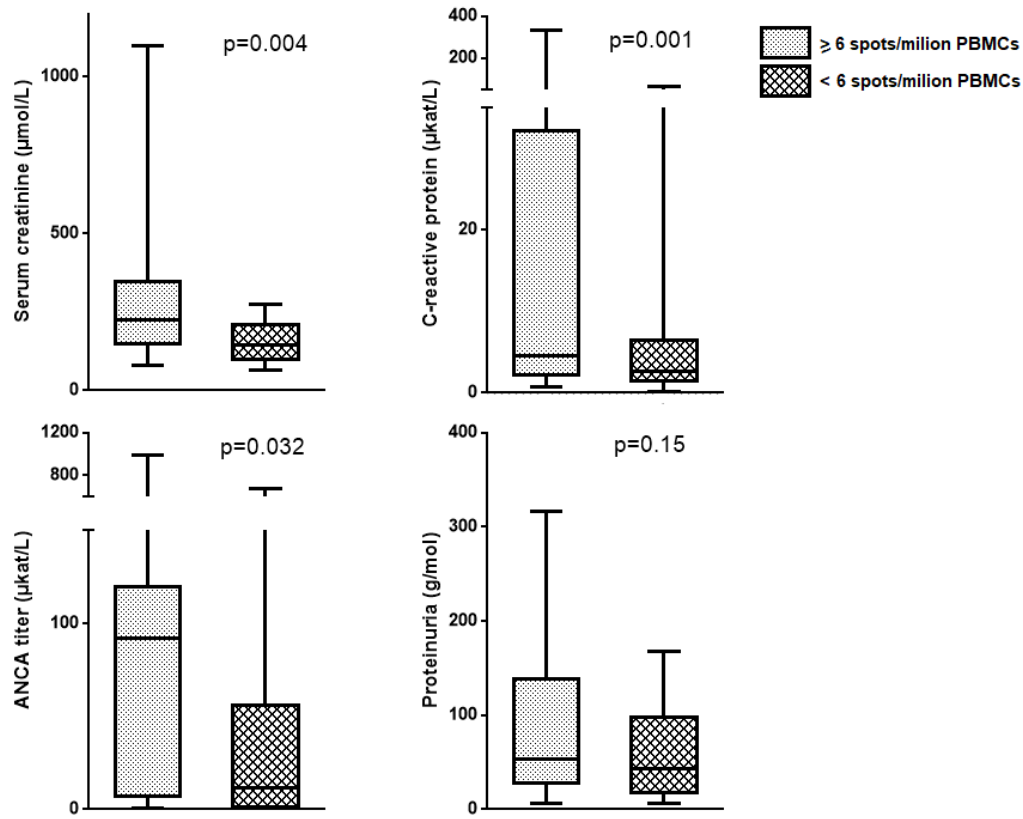
Figure 3. Comparison of clinical parameters among the two groups of AAV patients defined by the cut-off of 6 spots/10 6 PBMCs. Patients above this cut-off showed higher serum creatinine, ANCA titer, and CRP levels compared to the rest. We did not find differences regarding to proteinuria. ANCA—anti-neutrophil cytoplasm antibodies; CRP—C-reactive protein.